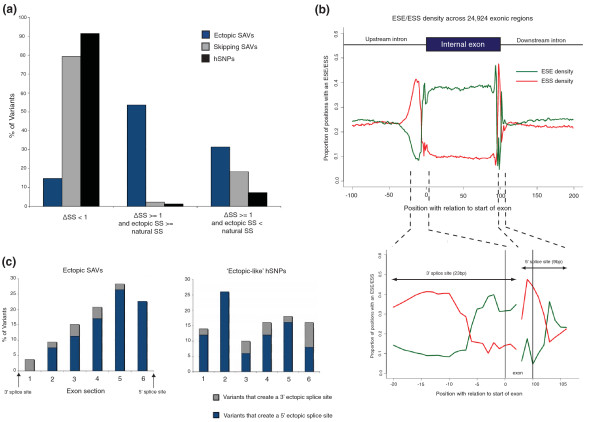
Features that characterize variants that activate de novo ectopic splice sites ('ectopic SAVs'). (a) Most ectopic SAVs, in contrast to hSNPs and skipping SAVs, have a large ΔSS value and create an ectopic splice site that is stronger than the natural splice site. (b) Hexamers in the vicinity of the splice junctions are largely made up of ESSs. The graph represents the proportion of positions occupied either by an ESE or ESS motif across approximately 25,000 internal exons. Each position on the graph represents the first base of a hexamer sliding across 100 bp of the upstream and downstream introns and the first and last 50 bp of the exon. (c) Ectopic SAVs are located predominantly in the vicinity of the splice site of the same type created, that is, the majority of ectopic splice sites created are 5' ectopic sites and are located towards the end of the exon close to the 5' splice site. hSNPs that create a strong ectopic splice site computationally ('ectopic-like' hSNPs) are distributed across the exon in quite the opposite way, indicating the same constraints do not apply to these variants.